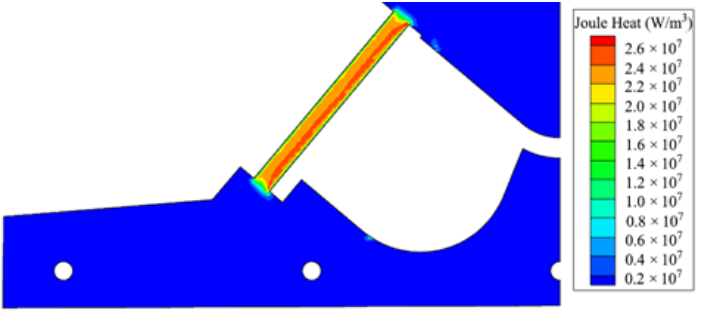
Figure 11. Joule heat distribution in